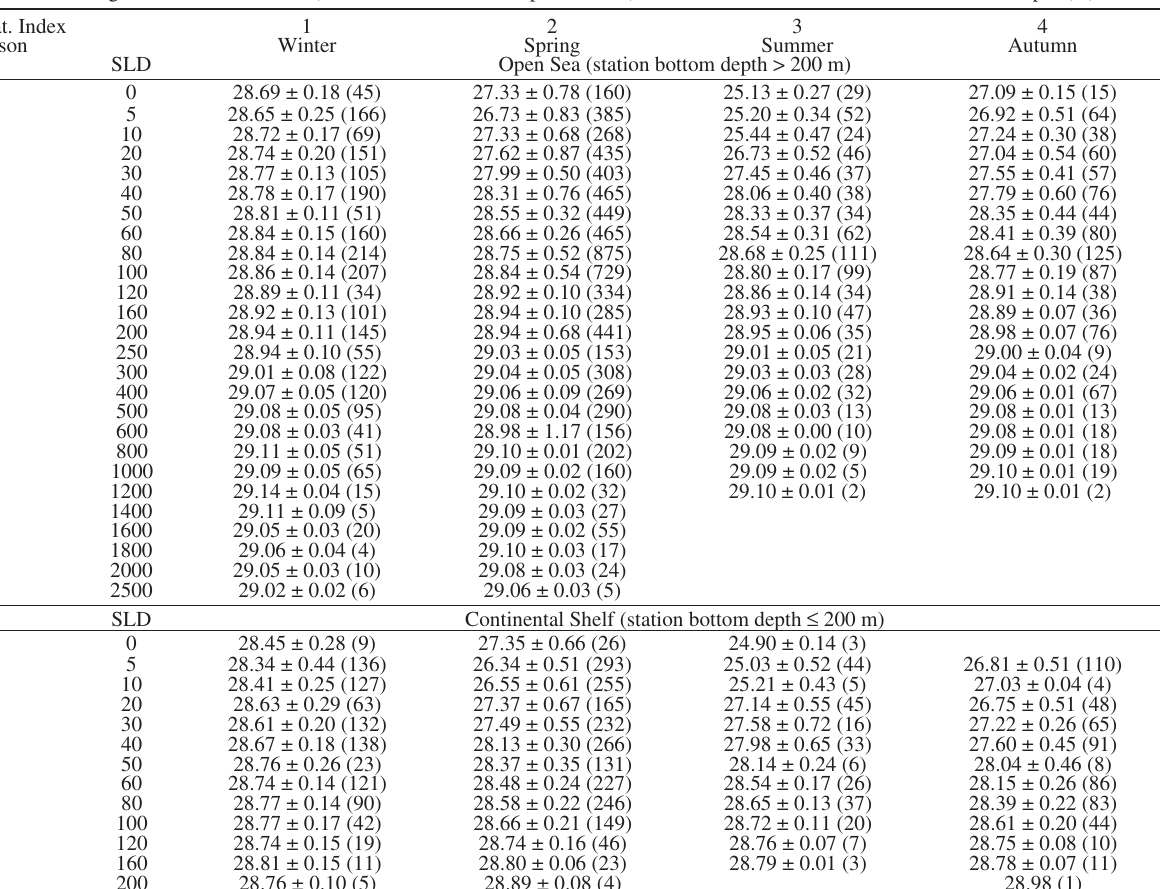
Table S11. – Density anomaly (kg m –3 ) with depth and stratification of the water column in the Catalan Sea (NW Mediterranean Sea). Shown are average ± standard deviation (number of data between parentheses). SL, Standard Level; SLD, Standard Level Depth